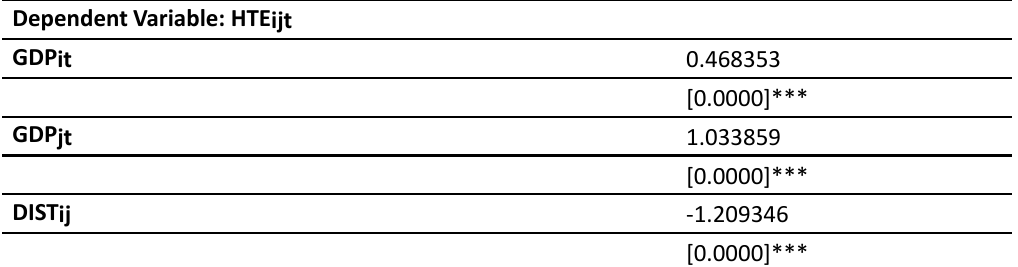
Table 1: Equation Estimation Result on GLS Panel